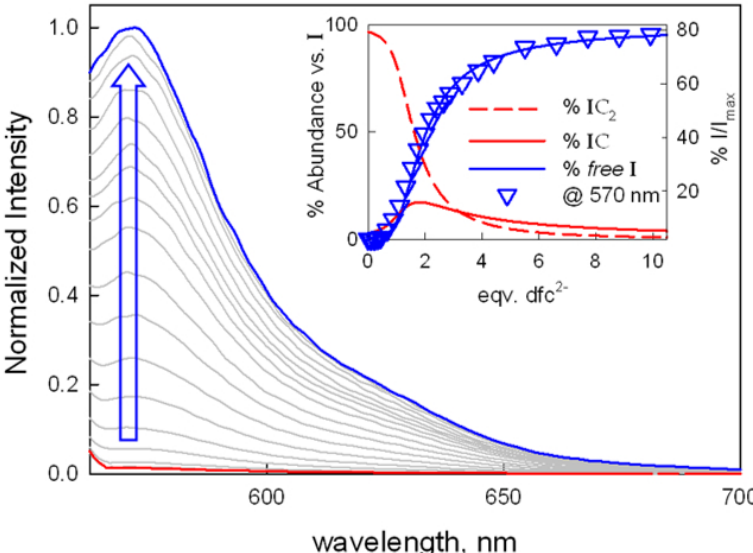
Figure 4. Normalized emission spectra taken upon titration of the chemosensing ensemble solution (0.25 µ M I; 50 µ M C, λ exc = 548 nm) with dfc 2 − (as the TBA salt) in H 2 O:CH 3 CN 1:4 at pH 7 (0.02 M HEPES buffer). The inset shows the titration profile, as % I/I max (I max = emission intensity of I in the absence of C ) vs. eqv. of the dicarboxylate anion, with the superimposed distribution diagram of the indicator containing species ( I = 6-TAMRA; C = [Cu 2 L] 4+ ; IC and IC 2 = 1:1 and 1:2 I:C adducts, respectively).